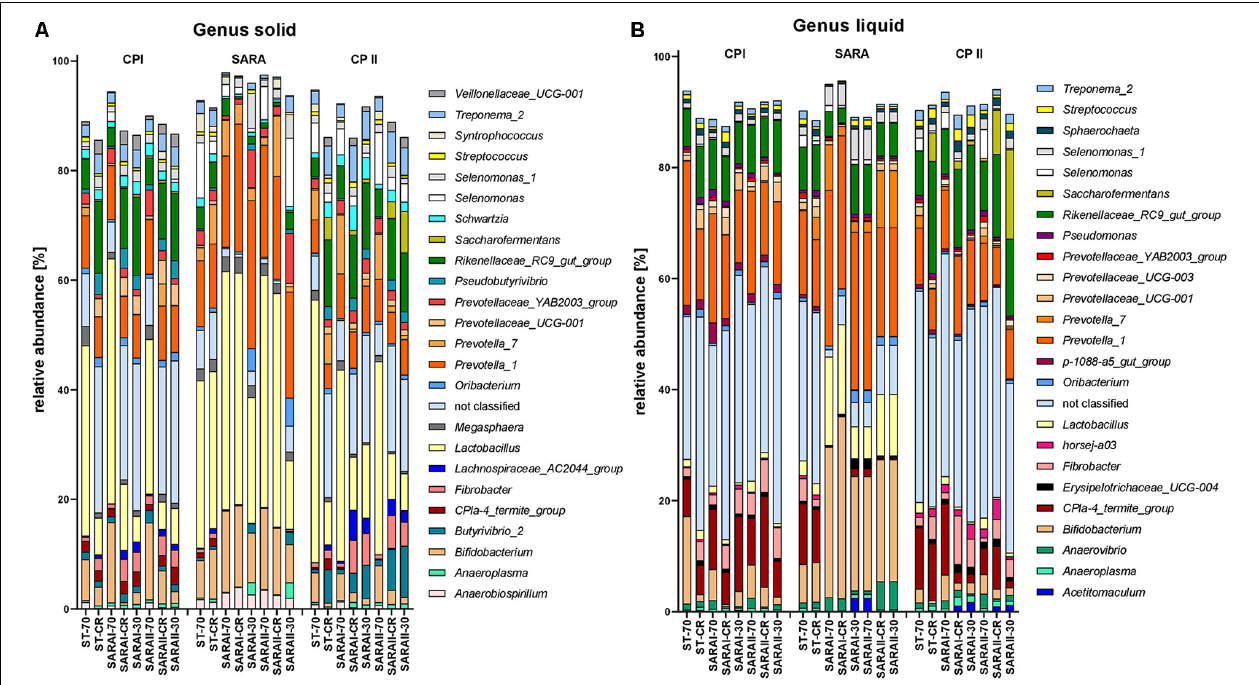
FIGURE 7 | Relative abundances on genus level detected by the PacBio amplicon sequencing approach for the solid (A) and liquid (B) phases. Only the 25 most abundant genera of each phase are displayed. Relative abundances for each treatment group are shown for all three experimental periods (CP I = control period I, SARA = subacute acidosis period, CP II = control period II). Treatment groups are labeled as follows: ST-70 = standard buffer, 70% concentrate; ST-CR = standard buffer, changing ratio; SARAI-70 = SARA I buffer, 70% concentrate; SARAI-30 = SARA I buffer, 30% concentrate; SARAI-CR = SARA I buffer, changing ratio; SARAII-70 = SARA II buffer, 70% concentrate; SARAII-30 = SARA II buffer, 30% concentrate; SARAII-CR = SARA II buffer, changing